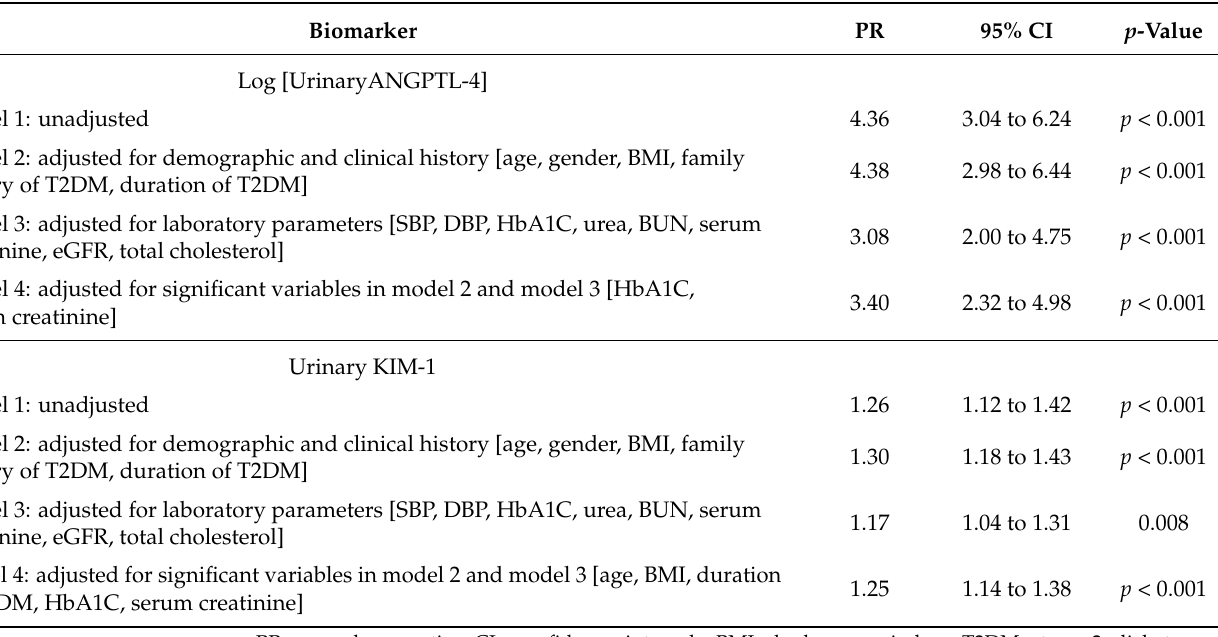
Table 3. Association between urinary markers (ANGPTL-4 and KIM-1) and diabetic kidney disease after adjustment for demographic, clinical, and laboratory